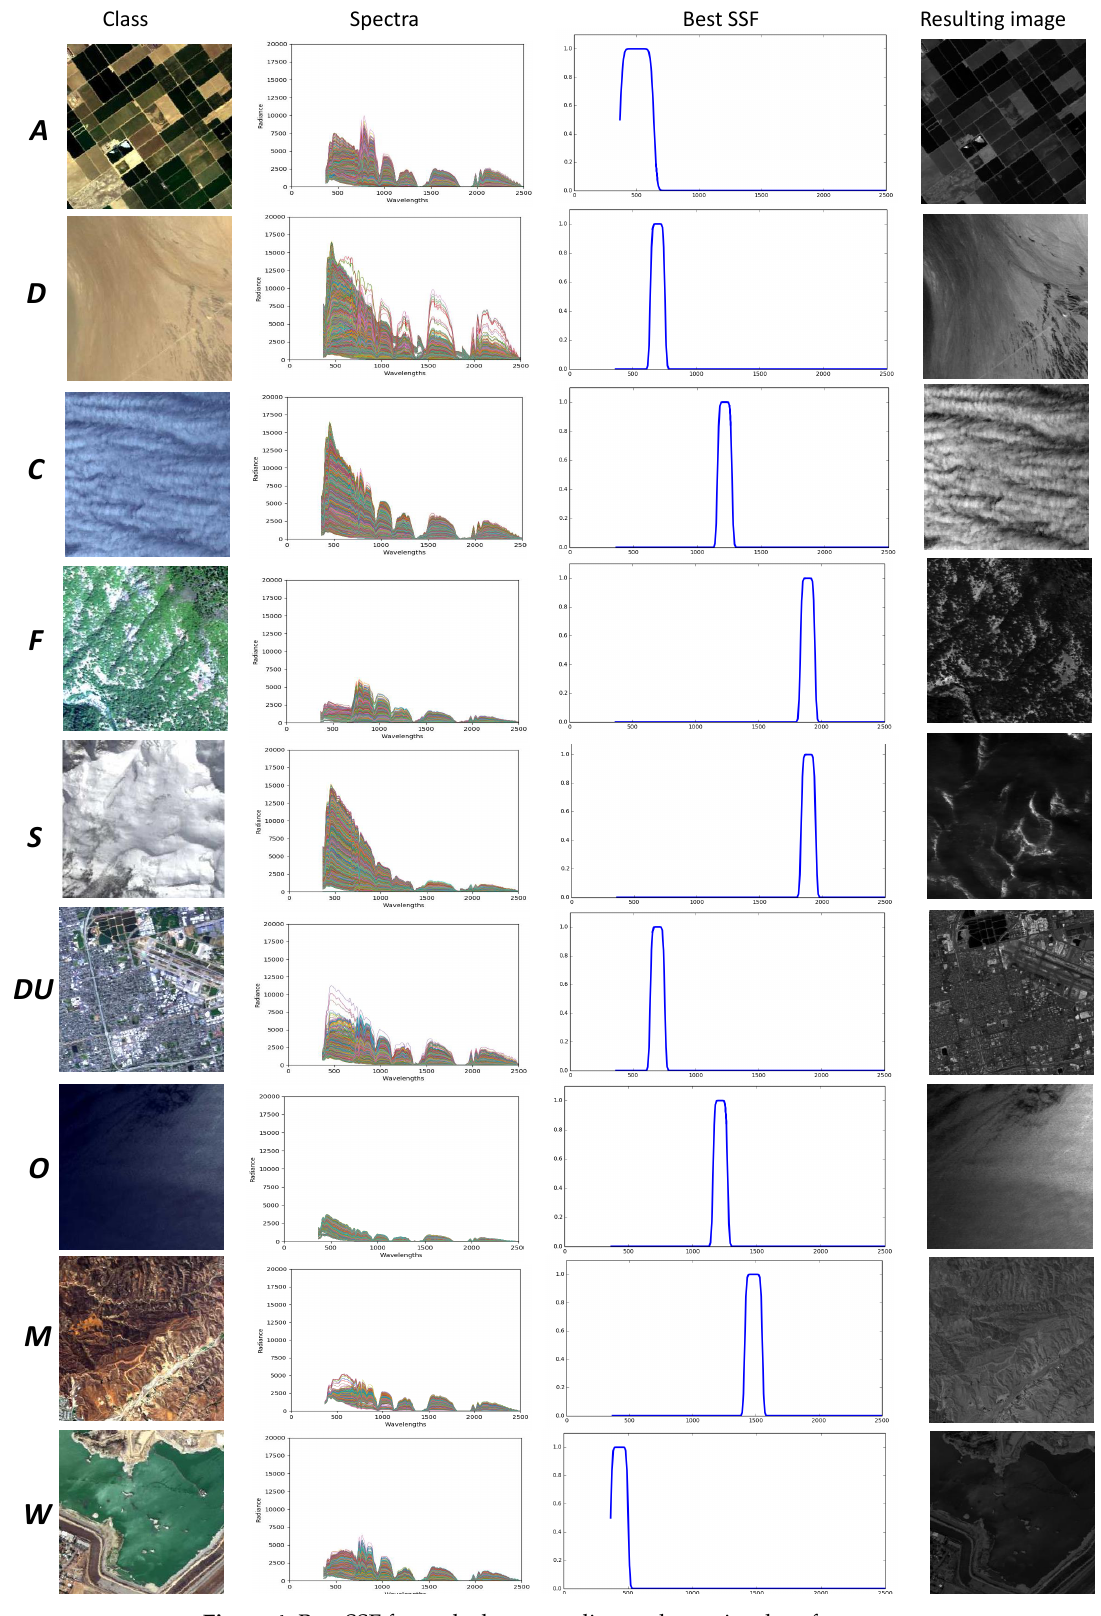
Figure 4. Best SSF for each class according to the retrieval